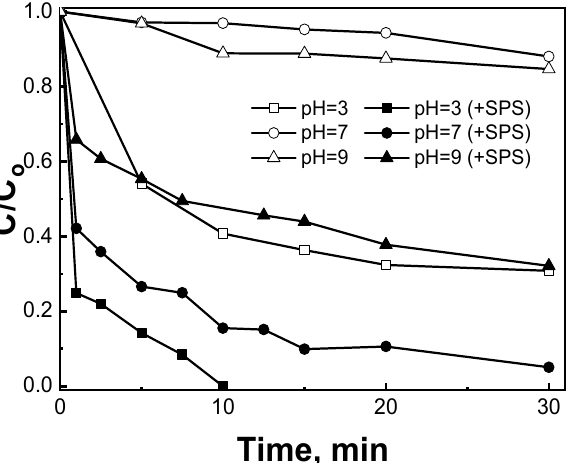
Figure 8. Effect of initial solution pH on the removal of 0.5 mg L − 1 SMX in UPW with 100 mg L − 1 biochar and in the presence or absence of 250 mg L − 1 SPS.